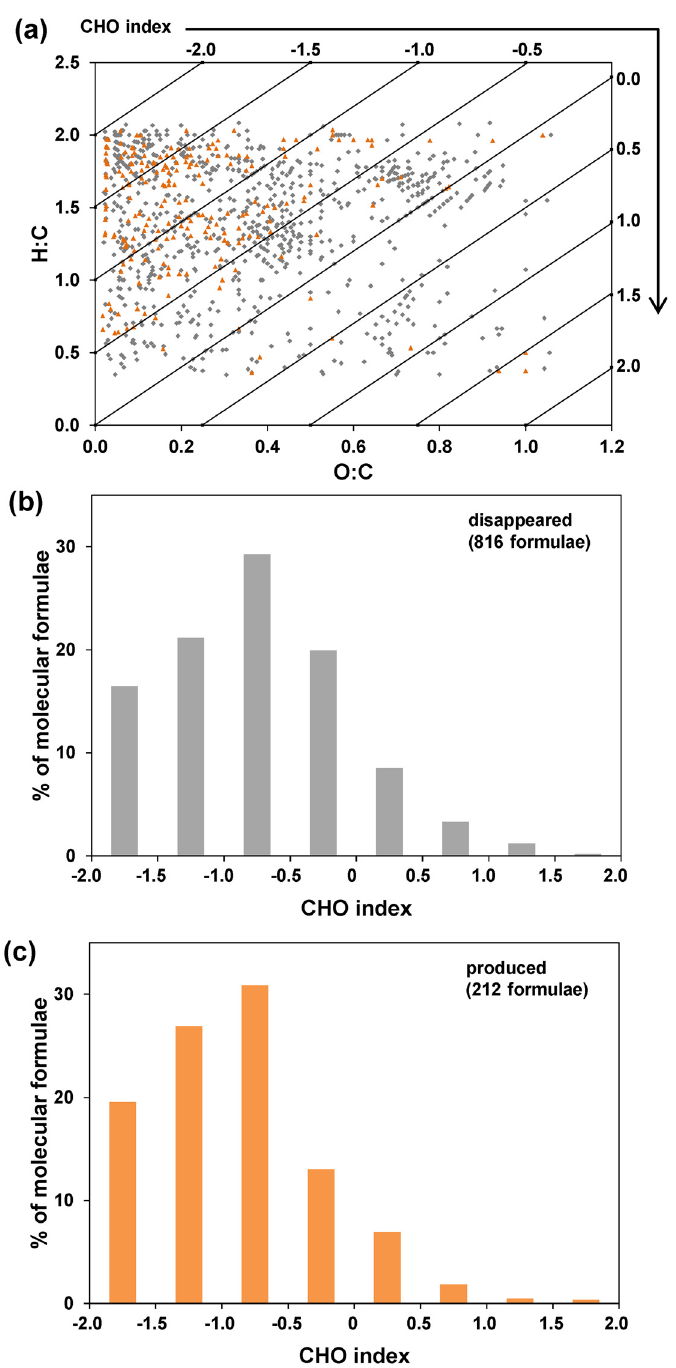
Fig 3. Illustration of the molecular formulae that were either degraded (grey color) or produced (orange color) in the WSF SOM during the 40-day incubation experiment. (a) van Krevelen diagram along with CHO index showing the molecular formulae that were either degraded (grey color) or produced (orange color) in the WSF SOM after incubation. (b) CHO Index plots of the number of molecular formulae that were either disappeared in the WSF after incubation (normalized to the total of 816 formulae) or (c) produced after incubation (normalized to the total of 212 formulae).